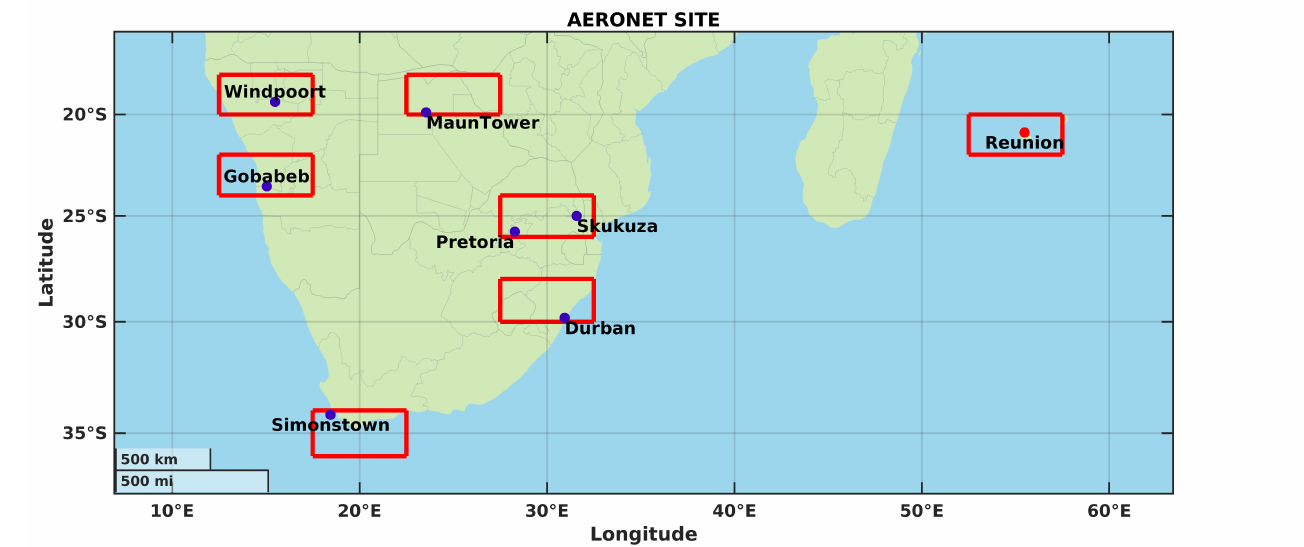
Figure A1 represents the 2.0° × 5.0° grid collection of CALIOP observations encom- passing the eight sun photometer sites. The red boxes follow the resolution grid of CALIOP L3 data.